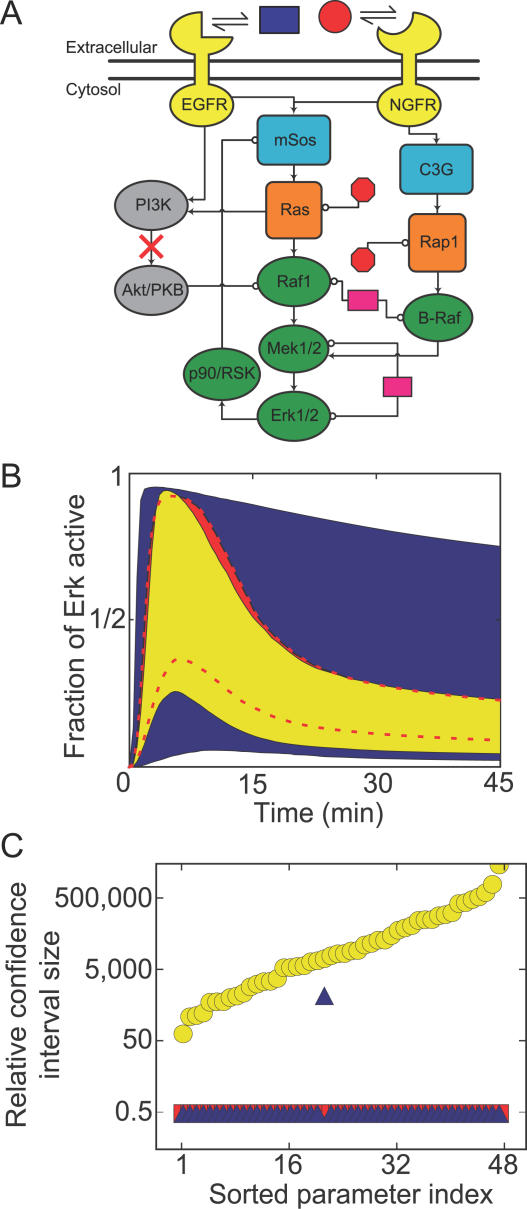
Parameter and Prediction Uncertainties(A) Our example prediction is for ERK activity upon EGF stimulation given PI3K inhibition in this 48-parameter model of growth-factor signaling in PC12 cells [21].(B) Shaded regions are 95% confidence intervals calculated via exhaustive Monte Carlo for our example prediction given various scenarios for constraining parameter values.(C) Plotted is the relative size Σ of the 95% confidence interval for each parameter.The scenarios represented are: (red, squares) all model parameters individually measured to high precision, (blue, triangles) all parameters precisely measured, except one estimated to low precision, (yellow, circles) all parameters collectively fit to 14 real cell-biology experiments. Precisely measured individual parameter values enable a tight prediction, (B) middle red band; but even one poorly known parameter can destroy predictive power, (B) wide blue band. In contrast, the collective fit yields a tight prediction, (B) tightest yellow band; but only very loose parameter constraints, (C) circles. The large parameter uncertainties from the collective fit, (C) circles, calculated here by Monte Carlo are qualitatively similar to those seen in the linearized fit to idealized data (Figure 3, model (i)). (For clarity, the dashed red lines trace the boundary of the red confidence interval.)